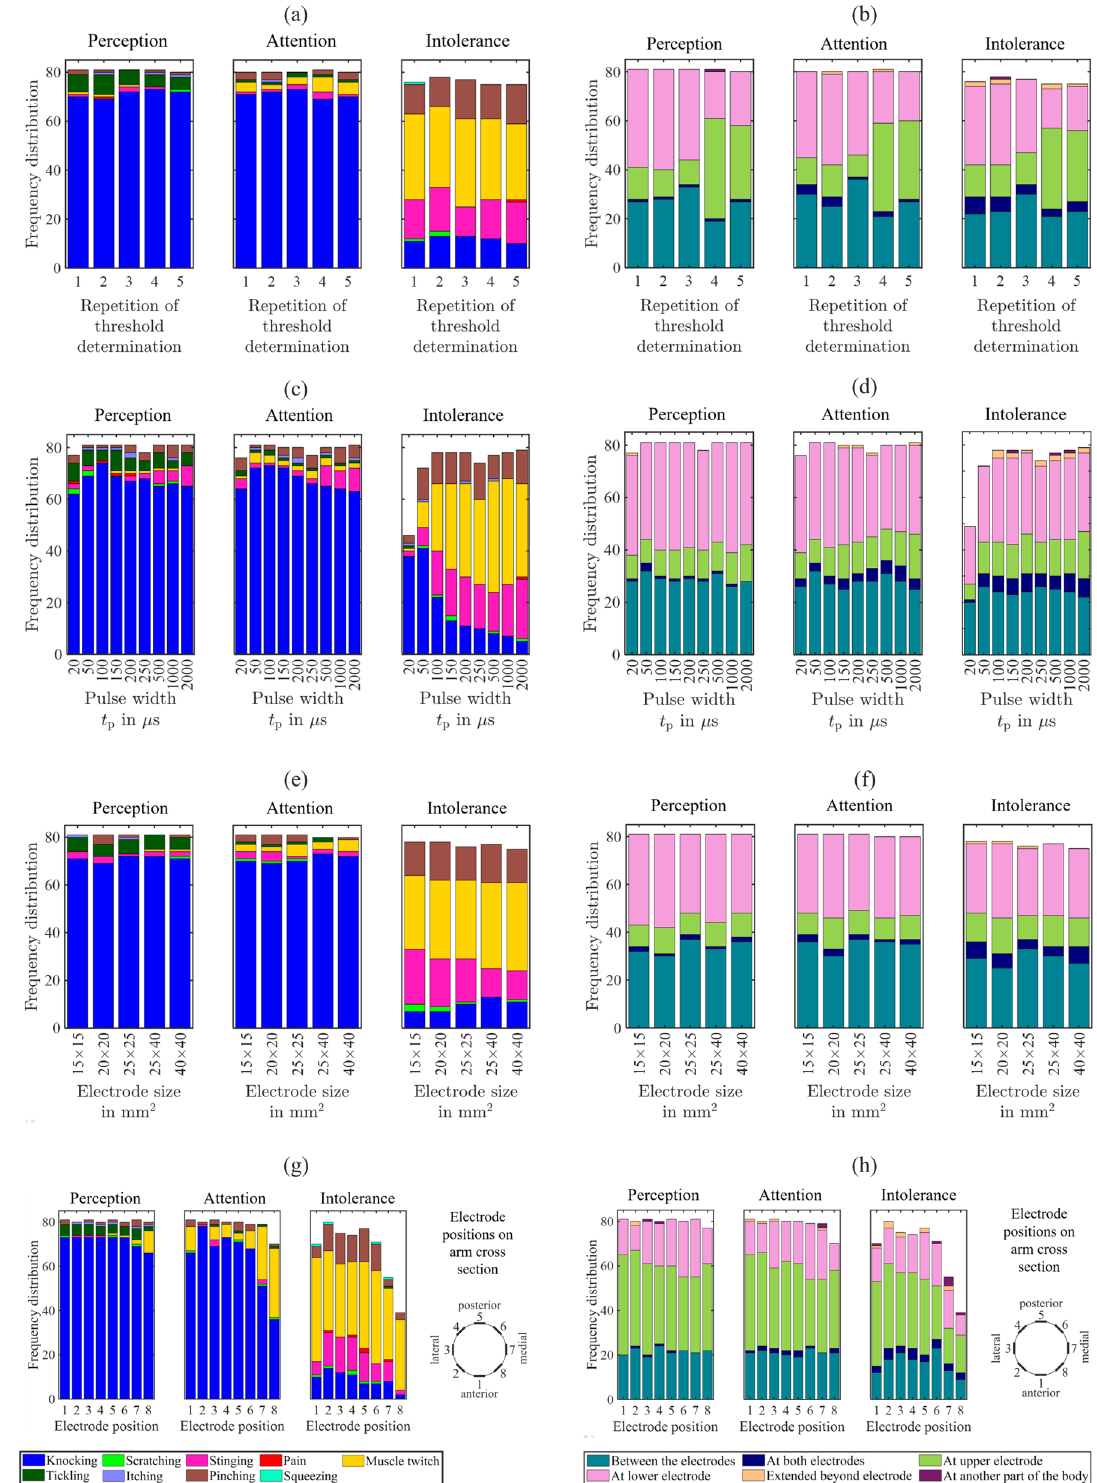
Figure 5. Qualitative (left column) and spatial (right column) perceptions for perception, attention and intolerance thresholds as absolute frequency distributions (upper limit is the number of participants ( n = 81 )) as a function of the: ( a , b ) repeated threshold determinations during the course of the experiment with electrode pair 3 (25 mm × 40 mm), ( c , d ) pulse width, ( e , f ) electrode size, and ( g , h ) electrode position. Please note that the x -axis is not to scale for ( c – f